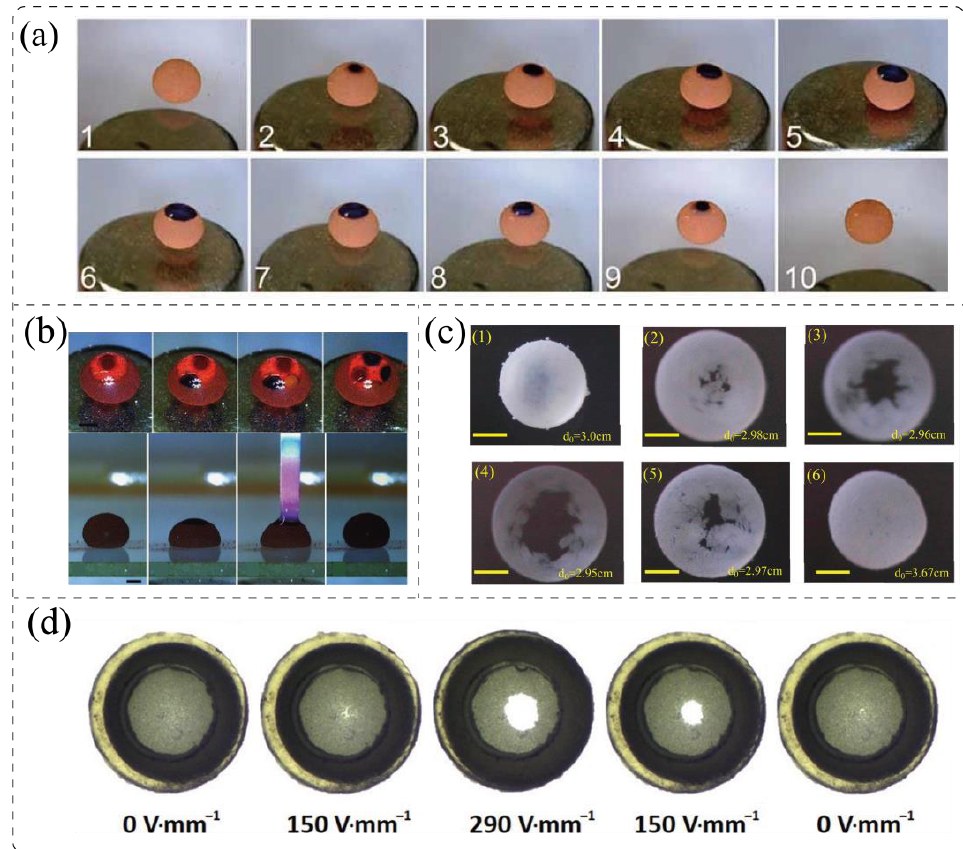
Figure 13. ( a ) Snapshots of the opening and closing of particle shells in LMs under a magnetic force [121] (Reproduced with permission from John Wiley and Sons, 2010). ( b ) The regent addition and chromatographic analysis in an opened magnetic LM [122] (Reproduced with permission from John Wiley and Sons, 2010). ( c ) Opening and closing of particle shells under the action of an acoustic field [126] (Reproduced with permission from American Chemical Society, 2015). ( d ) Opening and closing of particle shells under the action of an adjustable electric field [135] (Reproduced with permission from American Chemical Society, 2019).